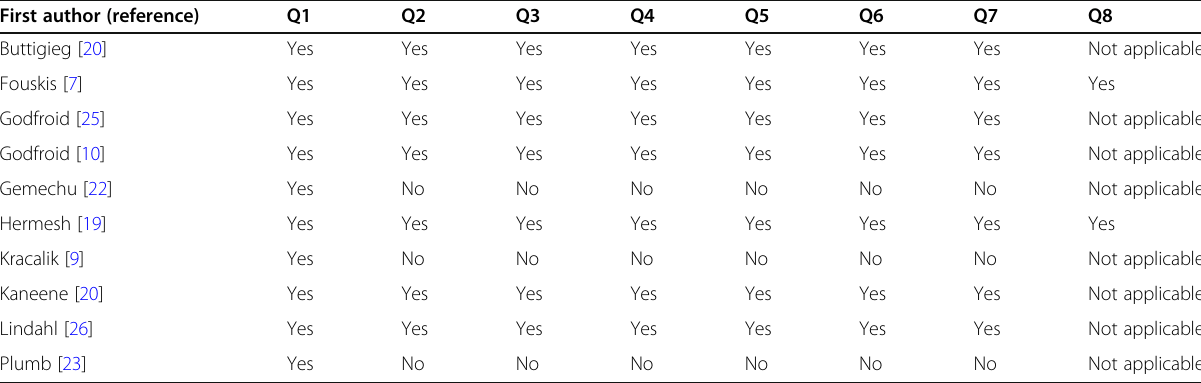
Table 2 Methodological assessment of the quality of selected